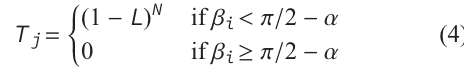
in dependence on its length L 1 for di ff erent laser-diode- emission angles ϕ and no reflection losses are depicted in figure 3. If reflectance R = 95% of the waveguide sidewalls is taken into account, the corresponding curves for two se- lected diode-emission angles are displayed in figure